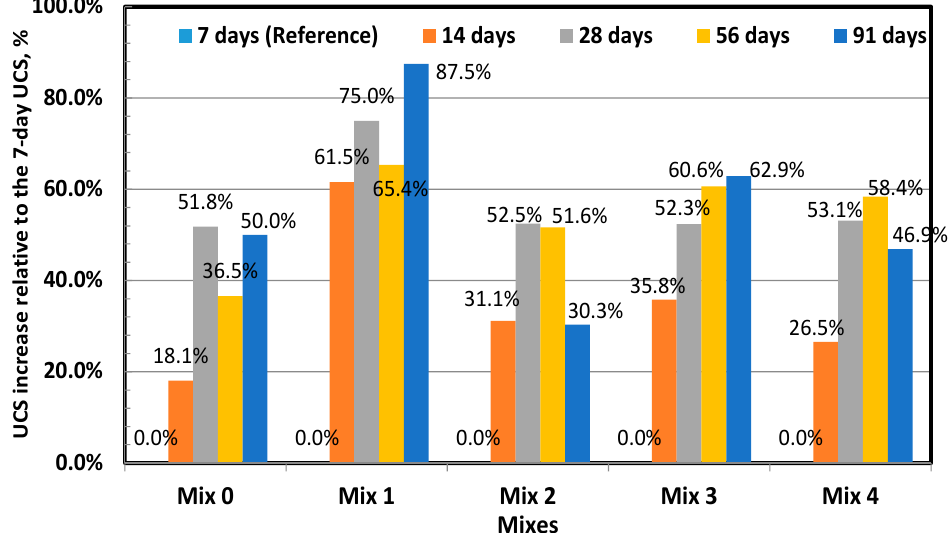
Figure 9. Compressive strength evolution over curing age within mixtures relative to the starting value after 7-day curing.